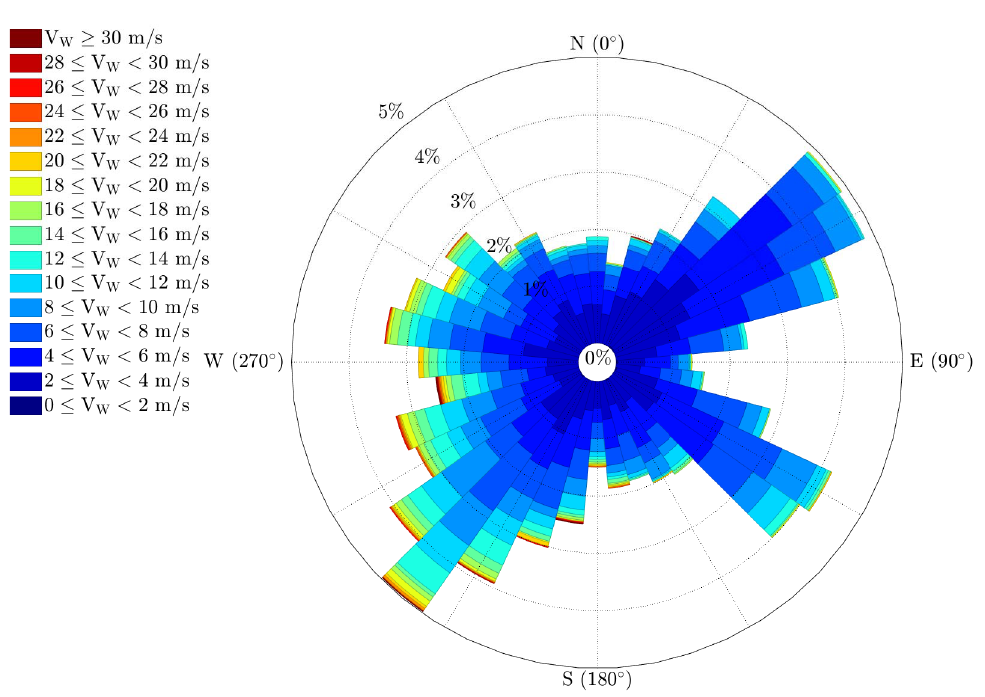
Figure 9. Wind rose diagram for all LLJ events observed at the Clausthal-Zellerfeld site at the altitude of the maximum wind